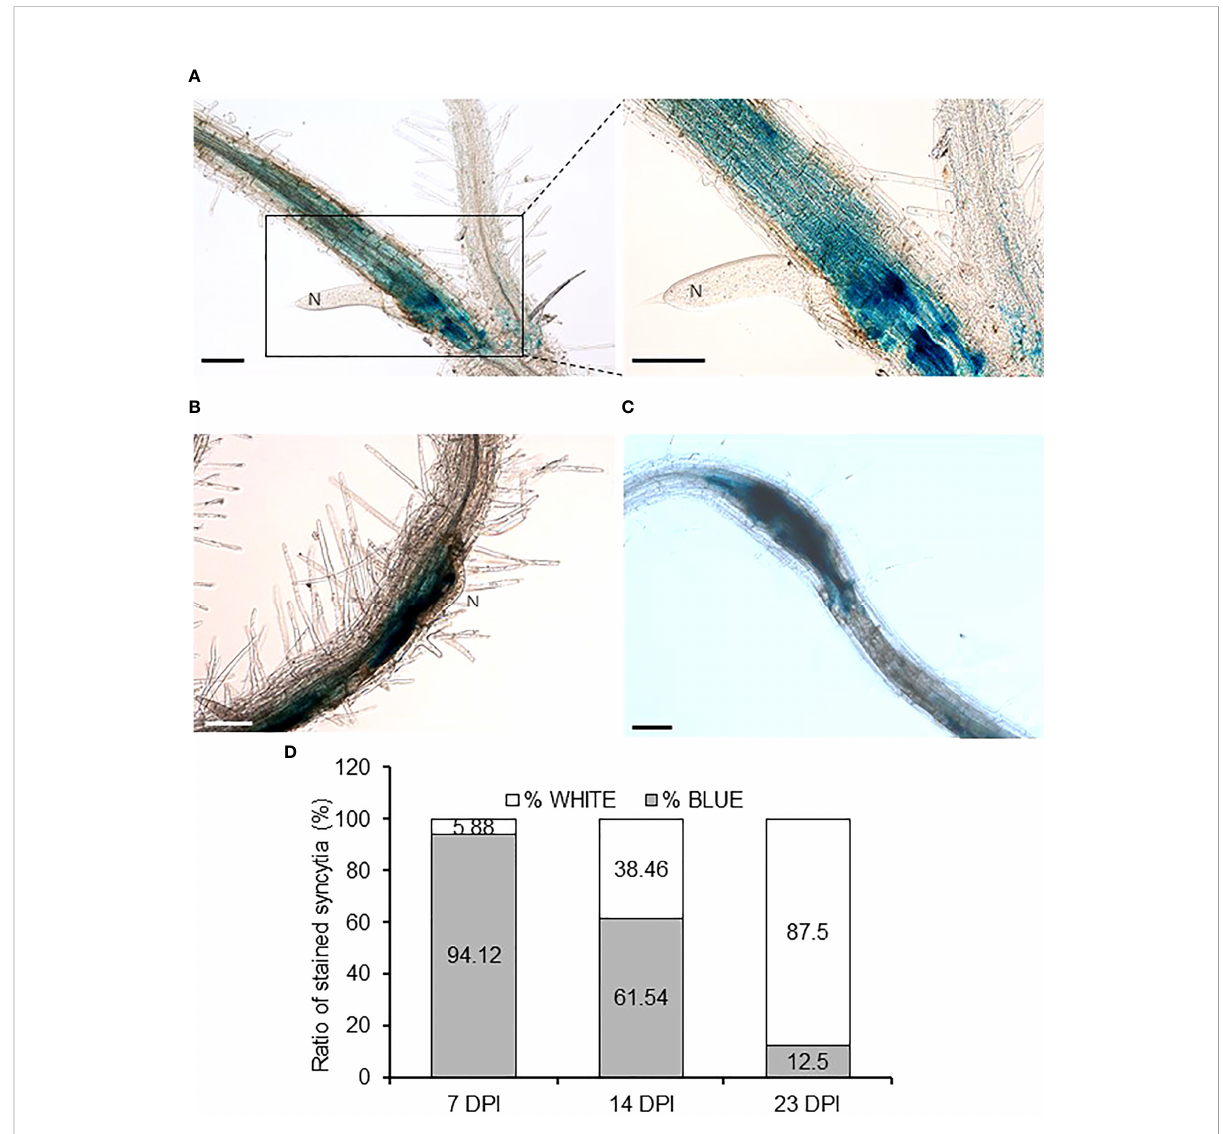
FIGURE 7 YUC4 promoter is active in Arabidopsis syncytia induced by Heterodera schachtii . (A – C) Roots of transgenic pYUC4::GUS Arabidopsis plants infected by H. schachtii at 7 DPI (right panel shows enlarged image of the syncytia) (A) , 14 DPI (B) and 23 DPI (C) showing intense GUS staining. Bars = 100 μm. (D) Percentages of GUS-positive syncytia from pYUC4::GUS plants at 7, 14 and 23 DPI. Three independent experiments were performed with at least 13 independent plants tested per infection point. Chi-square analysis [ c ² (2, 46) = 22.53] indicated that the distribution of blue and white galls is signi fi cantly different among the three infection stages,